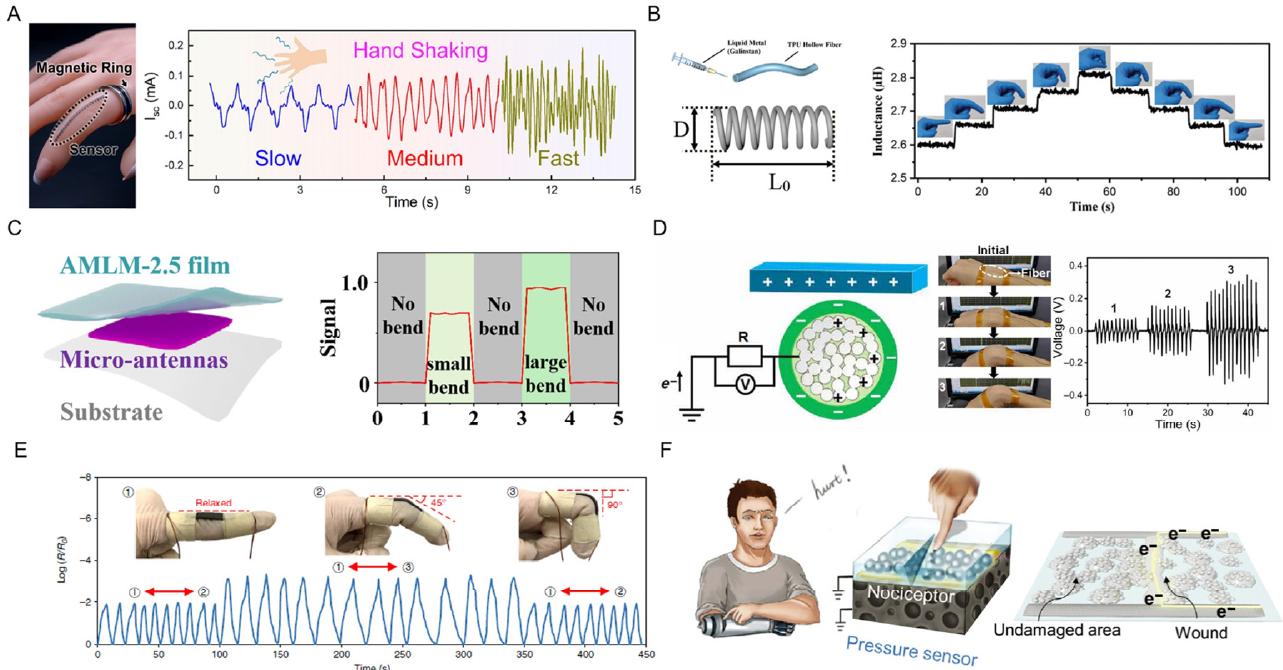
Figure 12. Mechanical sensors based on other mechanisms such as electromagnetic induction, electromagnetic shielding, electrical induction, triboelectricity, and piezoconductivity. ( A ) Photograph of the sensor on a finger ( left ). The output of sensor under hand trembling at slow, medium, and fast speed ( right ) [109]. Copyright: (2022) Elsevier. ( B ) Schematic of deformable conductive fiber fabricated from LM embedded into hollow elastomer tubes, and the design parameters of the helical inductive sensor ( left ). The inductance variation with the bending of the finger [110]. Copyright: (2021) Royal Society of Chemistry. ( C ) Schematic of the wearable strain sensor on an elbow ( left ), and signals induced by the micro-antennas layer responding to the deformation of the elbow [111]. Copyright: (2022) Elsevier. ( D ) The mechanism of the triboelectric sensor ( left ) and photograph when it was attached to a human wrist accompanied with corresponding voltage output [78]. Copyright: (2021) AAAS. ( E ) The application of the LM-based piezoconductive elastomer for finger bending detection [89]. Copyright: (2019) Springer Nature. ( F ) Schematic of the damage-detection sensor with the injury protection mechanism [72]. Copyright: (2022)